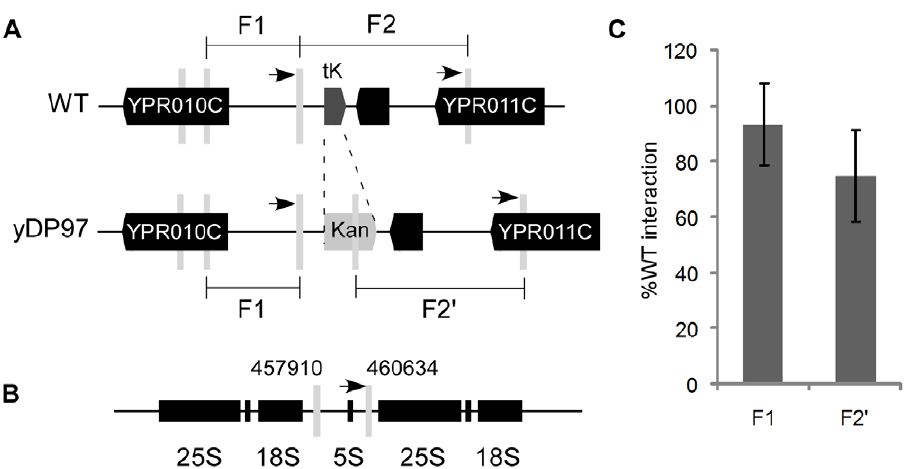
Figure 1. Deleting tRNA Lys tK(CUU)P from Chromosome XVI does not significantly perturb strong interactions between this locus and the ribosomal DNA repeats on Chromosome XII. A) Wild type (WT) S. cerevisiae strain (BY4741) had the lysine tRNA tK(CUU)P gene replaced with the Kan MX6 expression cassette. B) The 3C partner sequence was located across the 5S rDNA (Supplemental information). Grey bars denote Hin dIII restriction sites, arrows denote 3C primer positions. C) Quantitative 3C PCR demonstrates no significant reduction in interaction frequency for the F1 or F2/F2’ fragments due to removal of the tRNA gene. Results are expressed as percentage of WT F1 or F2 interactions and GAL1 was used to standardise between samples